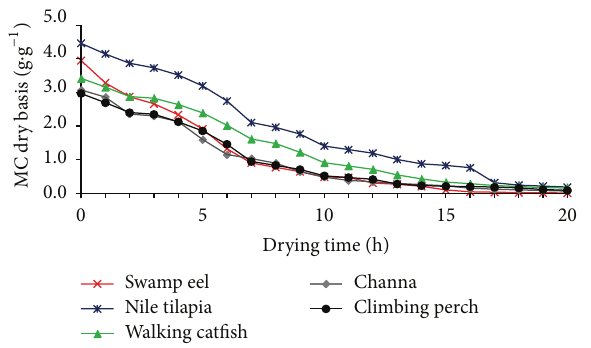
Figure 5: Changes of moisture content (db) of different fish meat samples with drying time for a typical experimental run in electric oven (EO).